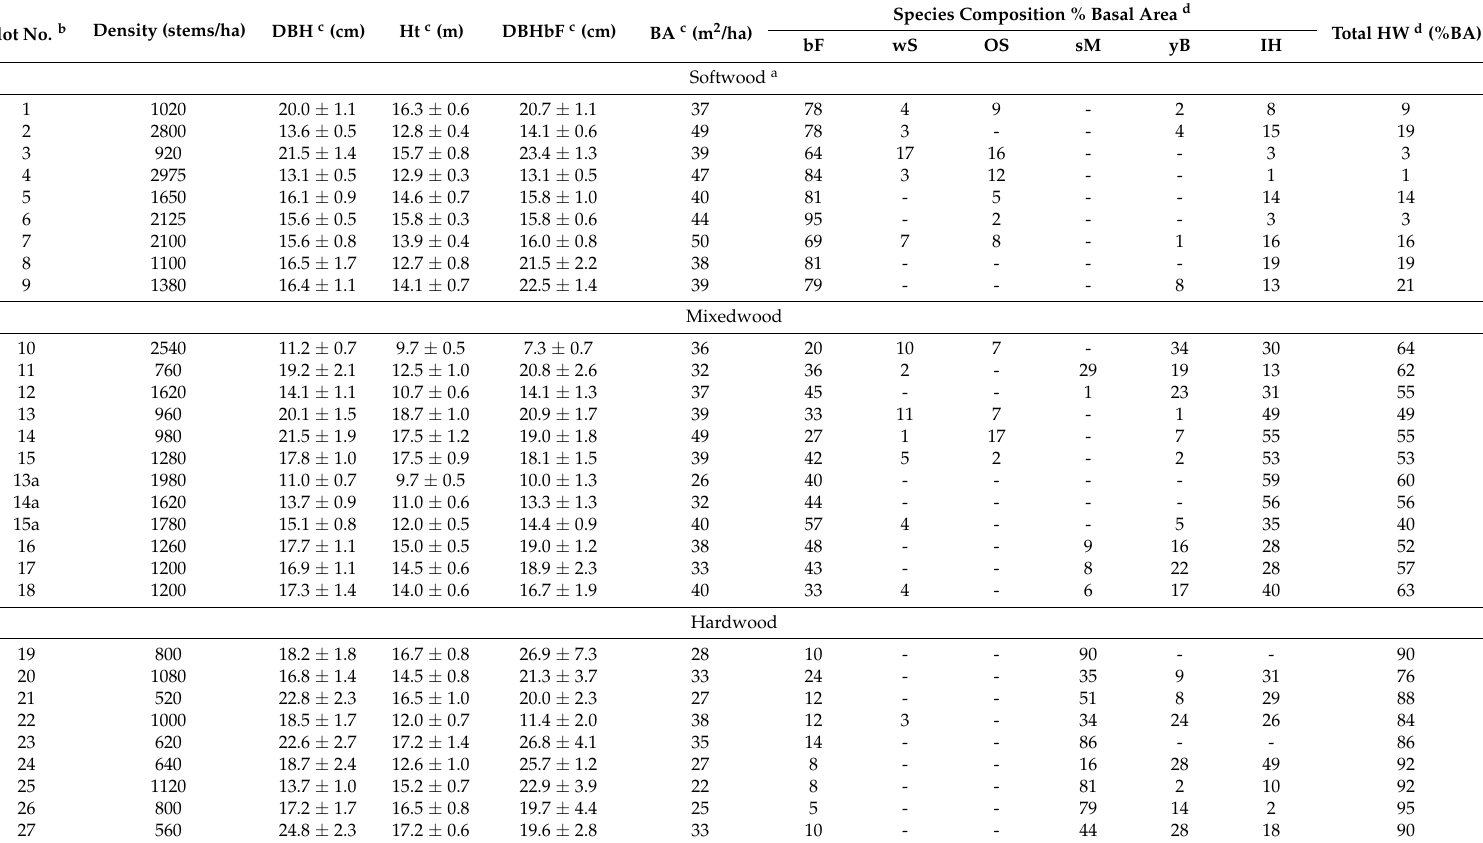
Table 1. Description of the 27 plots sampled near Amqui,